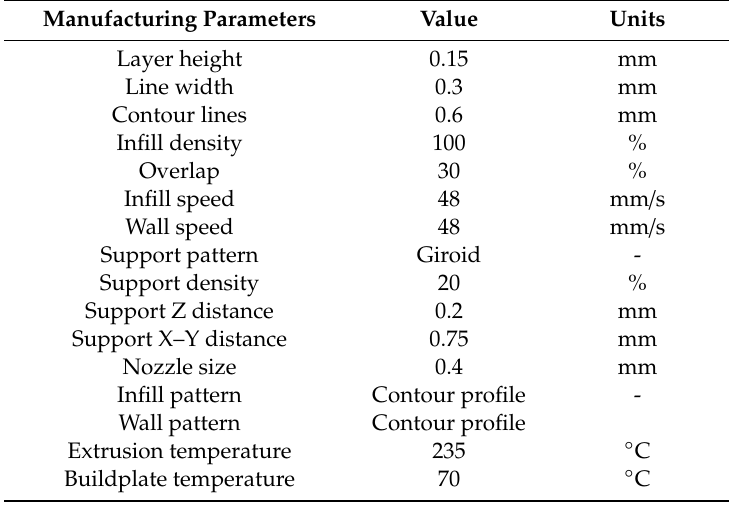
Table 3. Manufacturing parameters of the FDM process for the specimens and structural